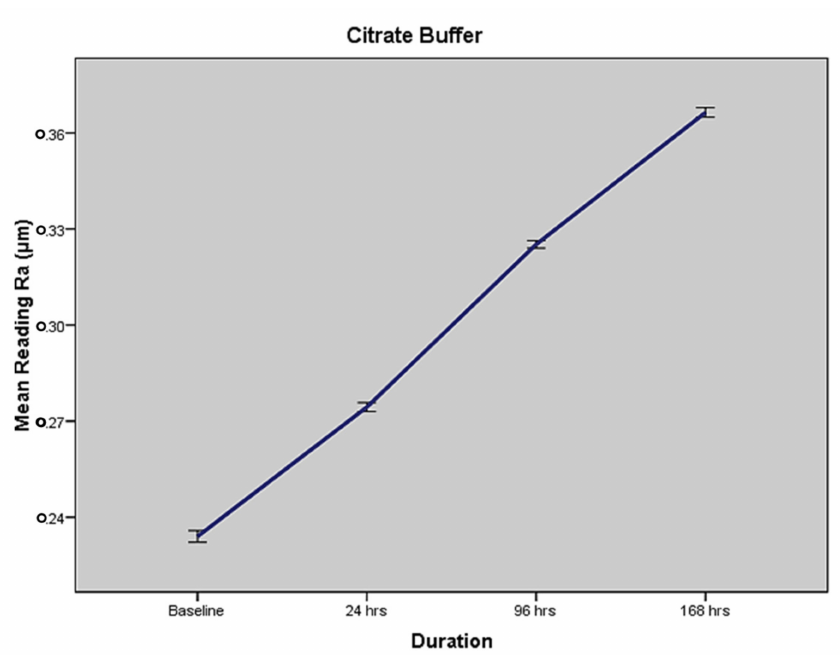
Figure 2. Time related change in surface roughness (mean Ra with standard error) for citrate buffer.